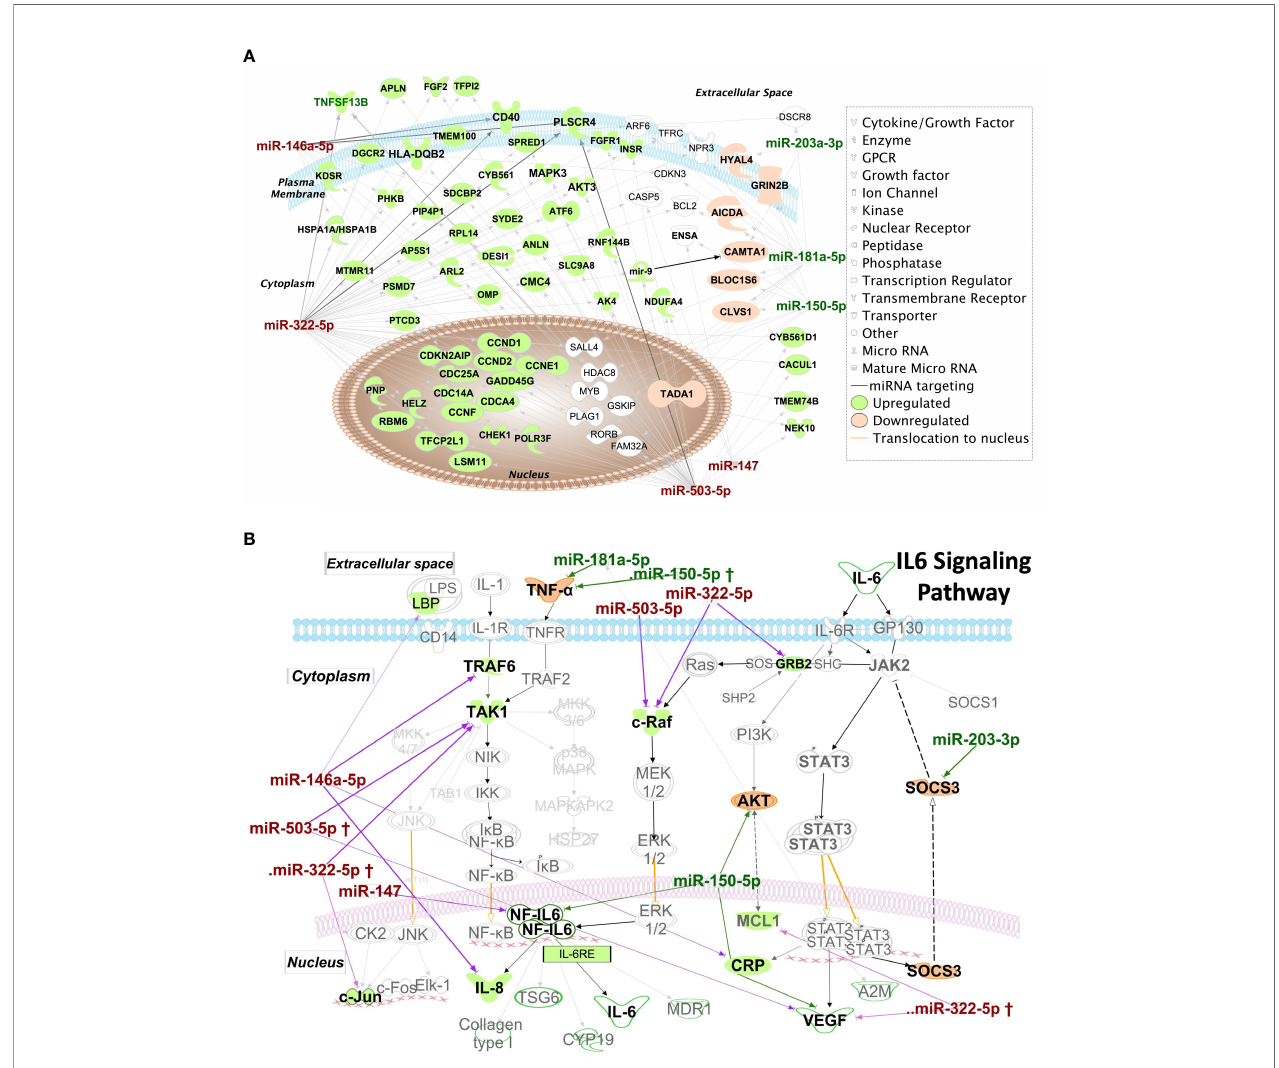
FIGURE 9 | IPA Network analysis of targeted miRNAs. (A) IPA Network map of miRNA hits and their mRNA targets. Genes targeted by >1 miRNA hits are shown according to their subcellular localization. Arrows represent post-transcriptional silencing of genes by connected miRNA. Downregulated miRNA hits are shown in red, upregulated ones are in green, whereas gene targets likely to be upregulated are shaded in green, and those likely to be downregulated are shaded in orange. Gene icons shaded in white are targeted by both up and downregulated miRNA. (B) Pathway analysis results suggest upregulation of IL-6 family cytokines and those transcribed through the IL-6-response element (IL6RE). In the NF- k B signaling, TRAF6 and TAK1 are targets of hits miR-146a-5p and miR-322-5p. Downregulation of these hits may lead to upregulation of TRAF6 and TAK1 and increase the transcription of the IL6RE, resulting in increased mRNA levels of cytokines. Of these, IL-8 is directly targeted by miR-146a-5p and its levels could be particularly upregulated with depletion of this miRNA. Also of key import is the targeting of SOCS3 by the upregulated miRNA miR-203-3p. SOCS3 is a negative regulator of the JAK2/STAT3 pathway and is required to turn off the pathway to prevent excessive production of